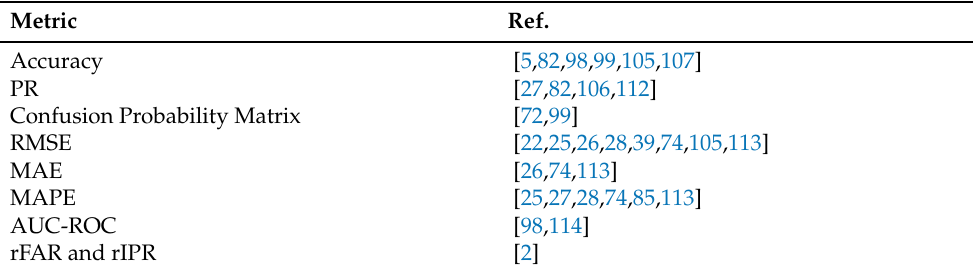
Table 4. Evaluation Metrics used in